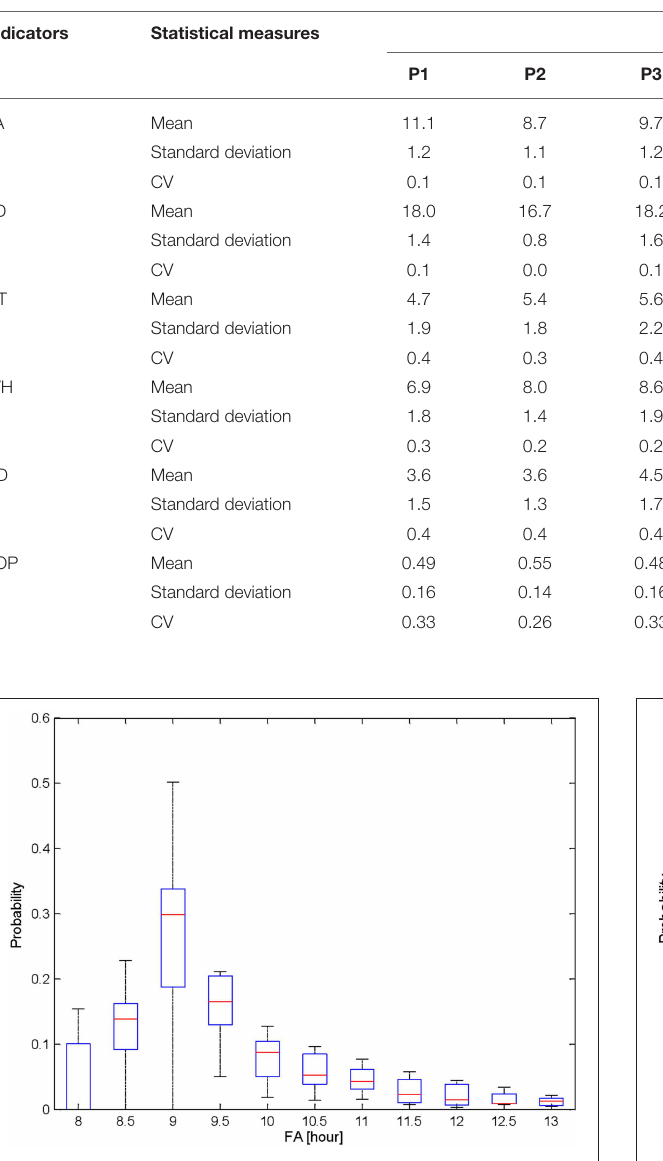
FIGURE 9 | First arrival time boxplot. Reproduced from Mahdavi and Tahmasebi (2015) with permission from A. Mahdavi, and F. Tahmasebi.